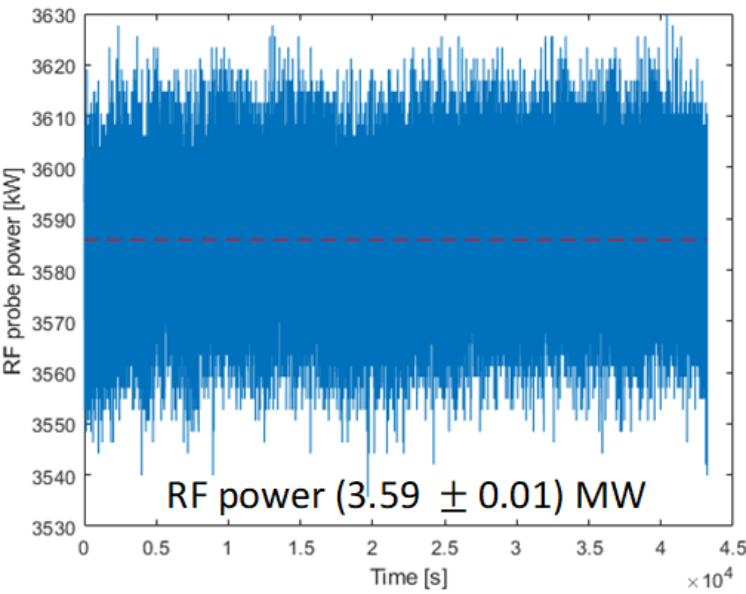
Figure 3. Stability measurement of the RF probe power in the ARES gun over 12